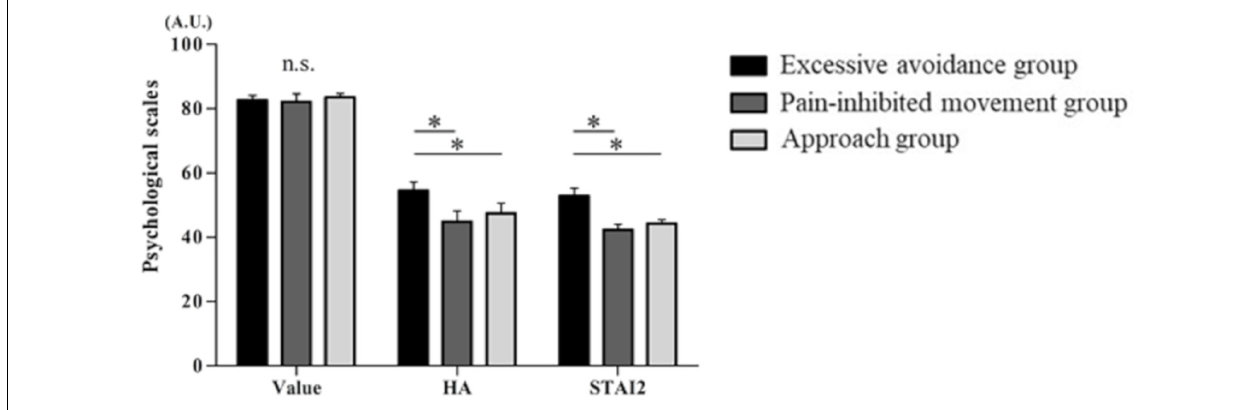
FIGURE 4 | Psychological scale. From the left, the values are as follows: the visual analog scale (VAS) scores reflecting the value of movement with pain, the State–Trait–Anxiety Inventory (STAI)-trait scores, and the harm avoidance (HA) scores of the Revised Temperament and Character Inventory (TCI-R) (mean ± SE). ∗ p < 0.05. TABLE 1 | Summary of results per cluster. Excessive avoidance Pain-inhibited movement